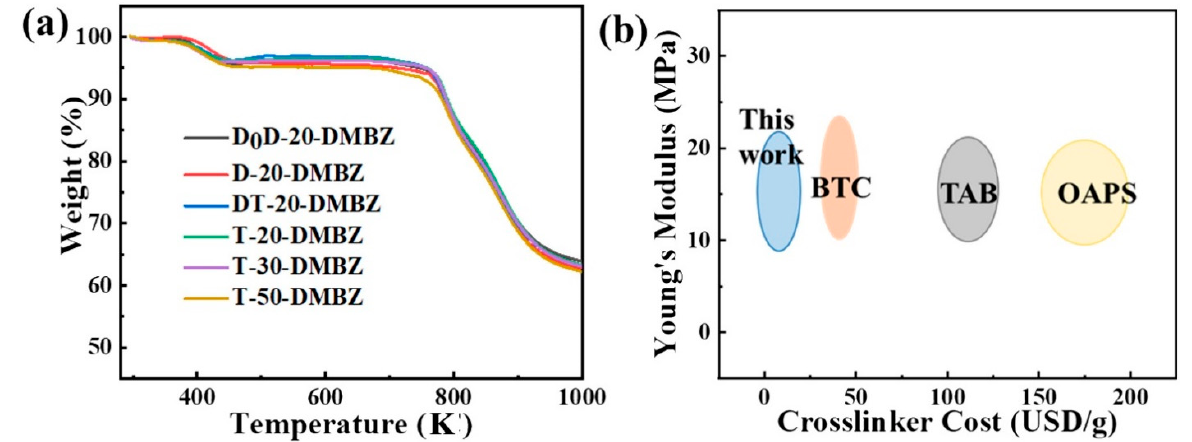
Figure 7. ( a ) Thermogravimetric analysis (TGA) curves in N 2 of the polyimide aerogels; ( b ) Com- son of Young’s modulus vs. cost of different parison of Young’s modulus vs. cost of different crosslinkers.